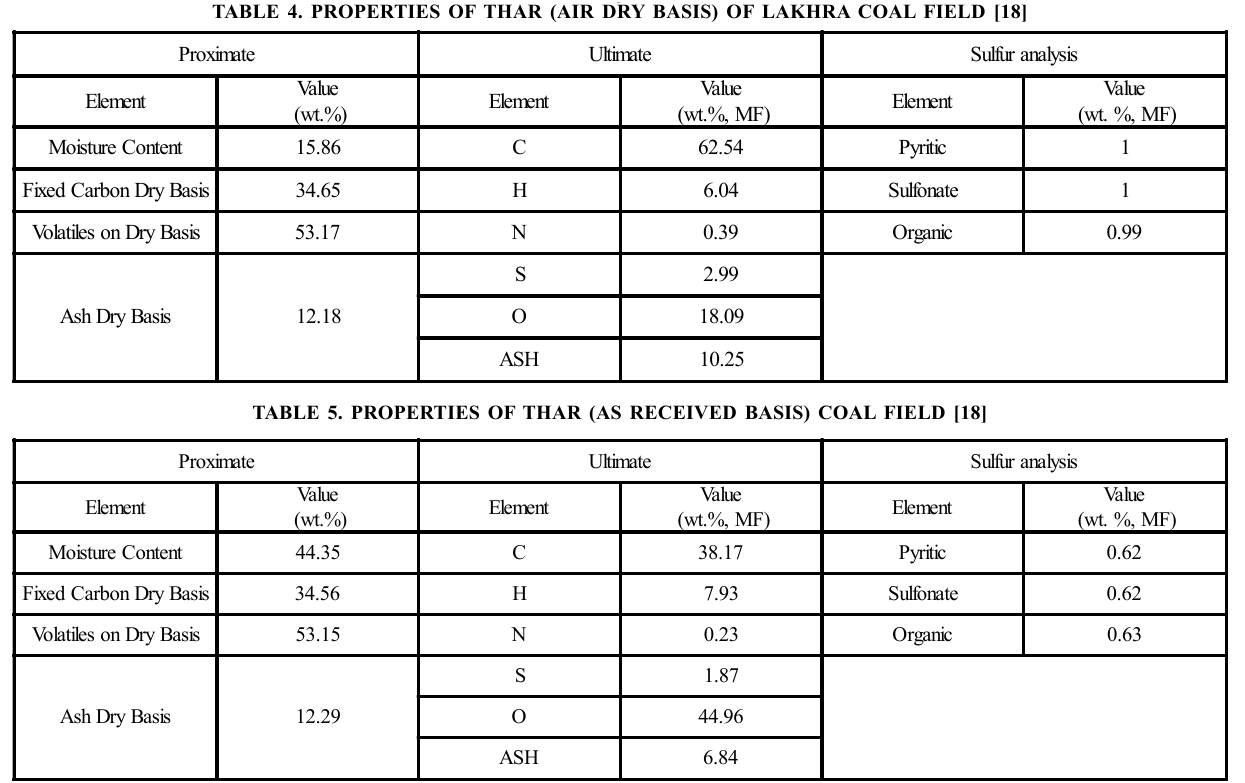
TABLE 6. DATA FEED STREAMS OF OXIDANT, STEAM AND FUEL [14]